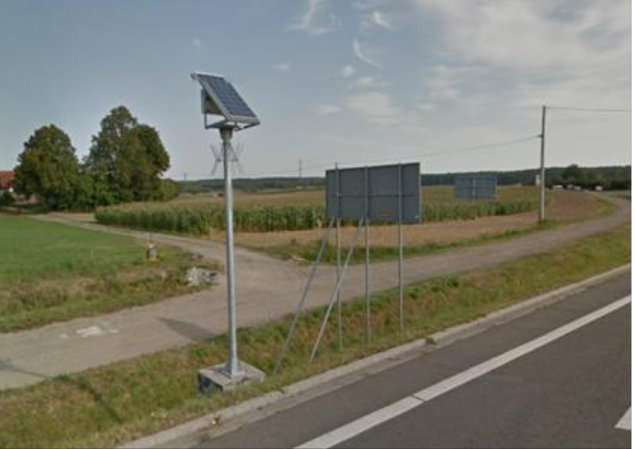
Figure 4. Location of a photovoltaic panel on national road No. 16, distance marker post 38 (Gi- etrzwałd) (126 + 250 km). Source: